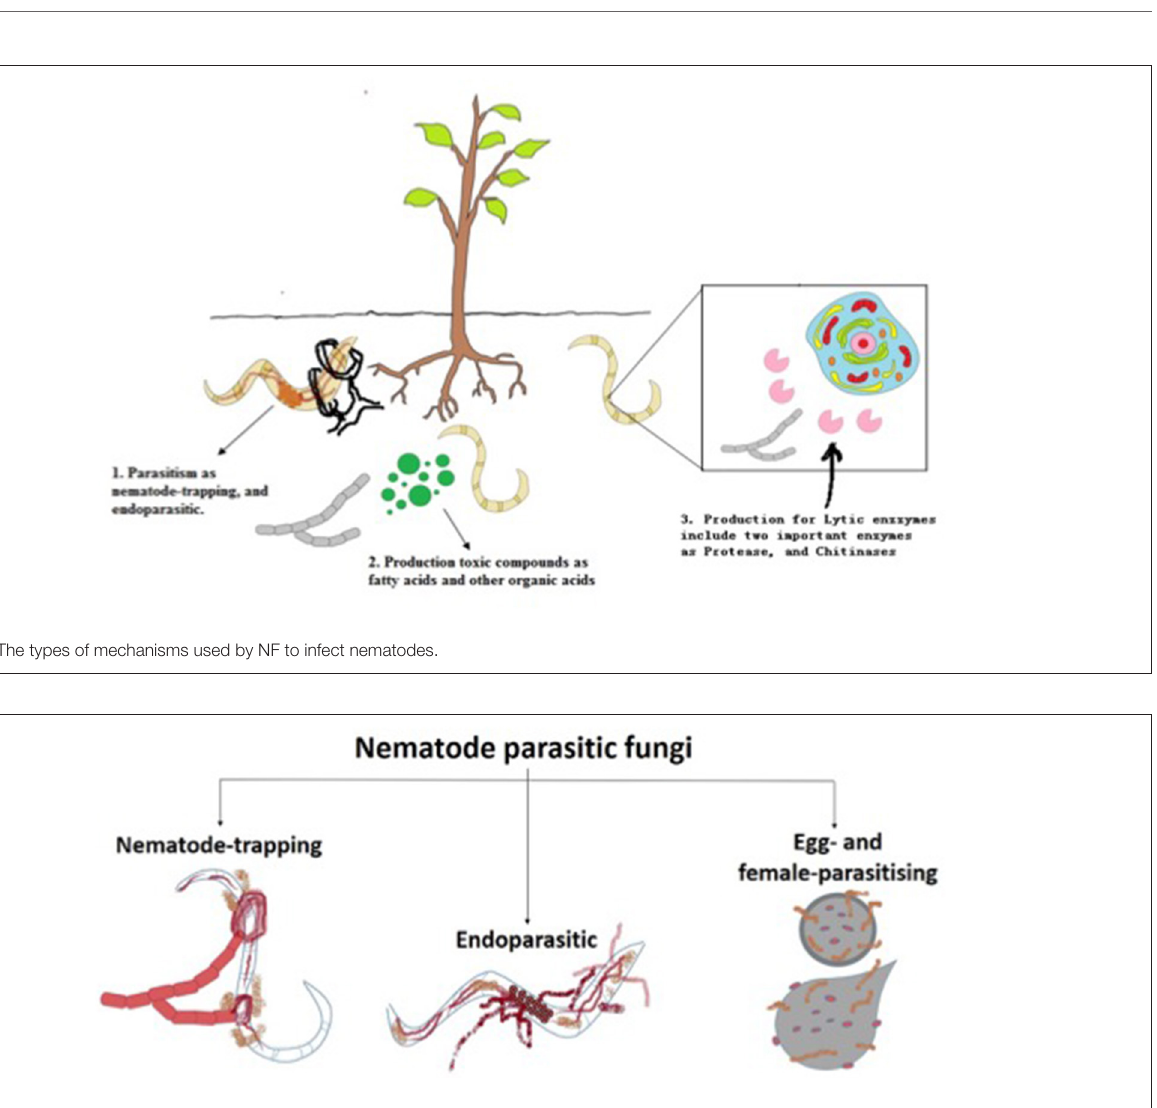
FIGURE 3 | Types of nematode parasitic